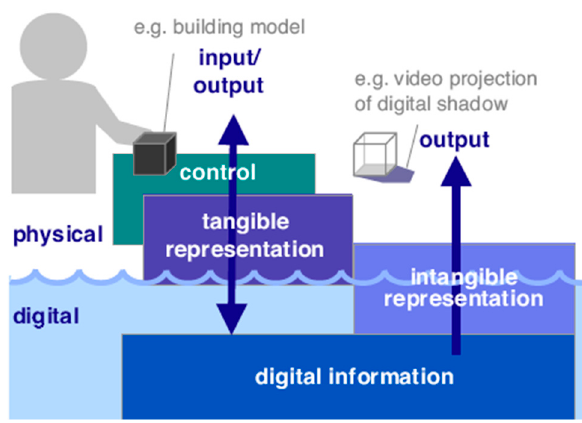
Figure 1. An illustration of the concept of tangible user interface (TUI) [29].